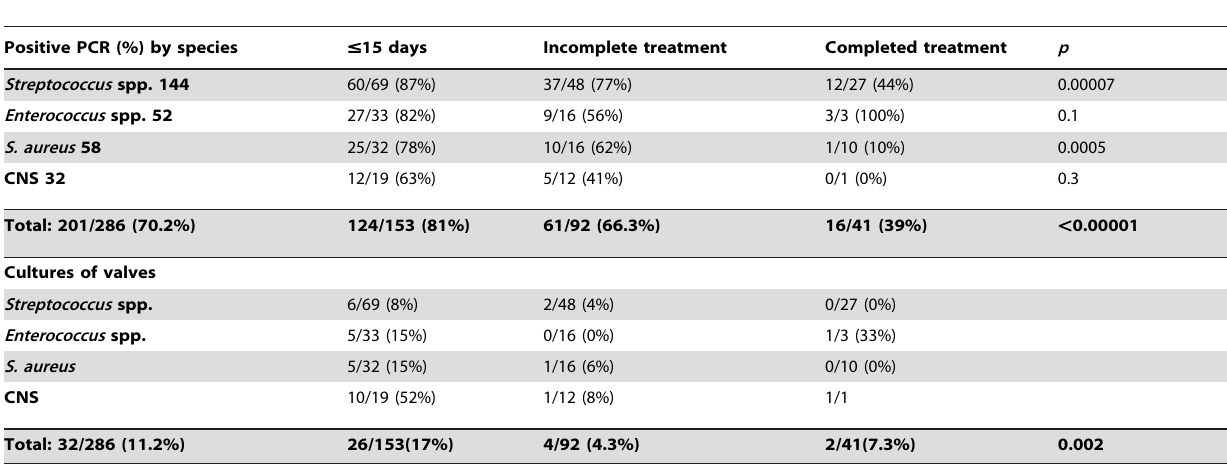
Table 2. Comparison of the PCR and valve bacteriologic culture results performed on heart valves from 286 patients at the time of surgery.